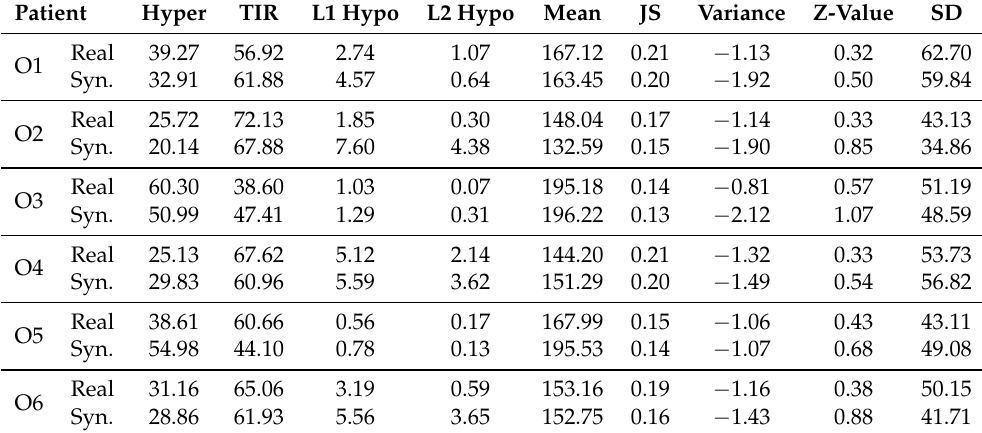
Table 6. Results obtained by comparing real and synthetic data for patients in the Ohio cohort. All p -values have been accepted, as they pass the acceptance threshold of 0.05.